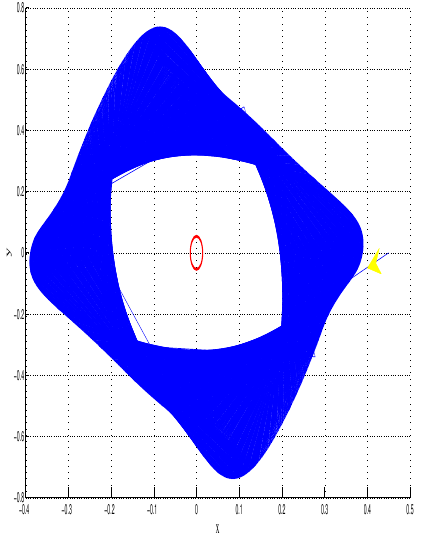
Figure 9. The numerical solution generated by the Euler scheme with h = 0 . 2 and t ∈ [0 , 1000] in Example 5.